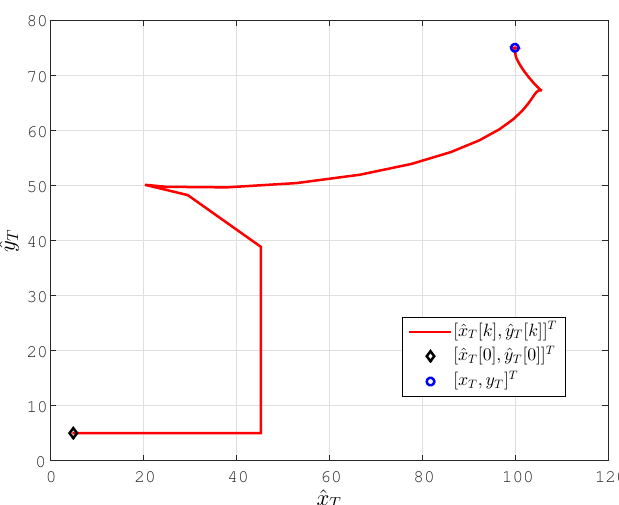
Figure 5. Lateral coordinate estimates ( ˆ x T [ k ] , ˆ y T [ k ]) ( m ) for the stationary target case.